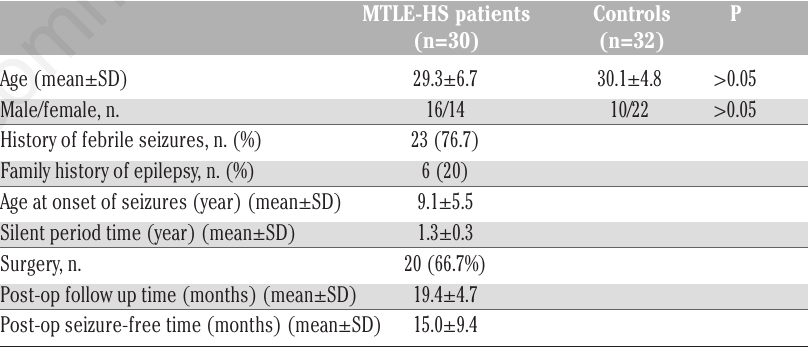
Table 1. Clinical characteristics of mesial temporal lobe epilepsy with hippocampal scle- rosis patients and controls.